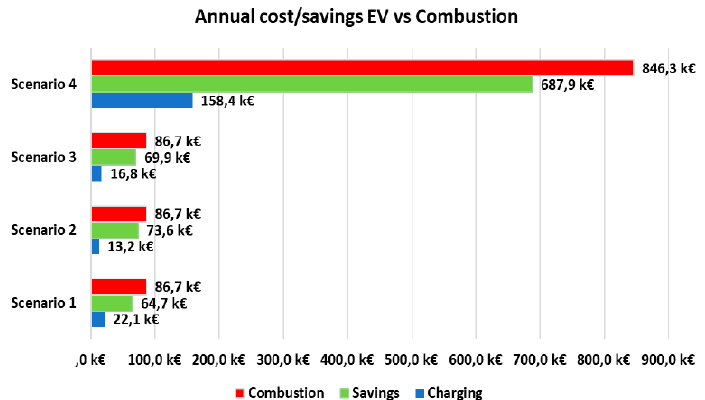
Figure 10. Annual cost/savings analysis for all scenarios.